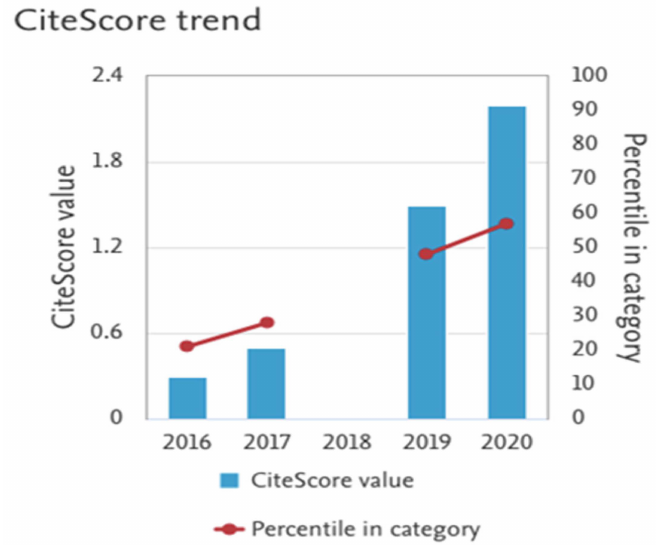
Figure 9. Citescore increasing trend for the analysed journal, which is reflected in higher percentiles.